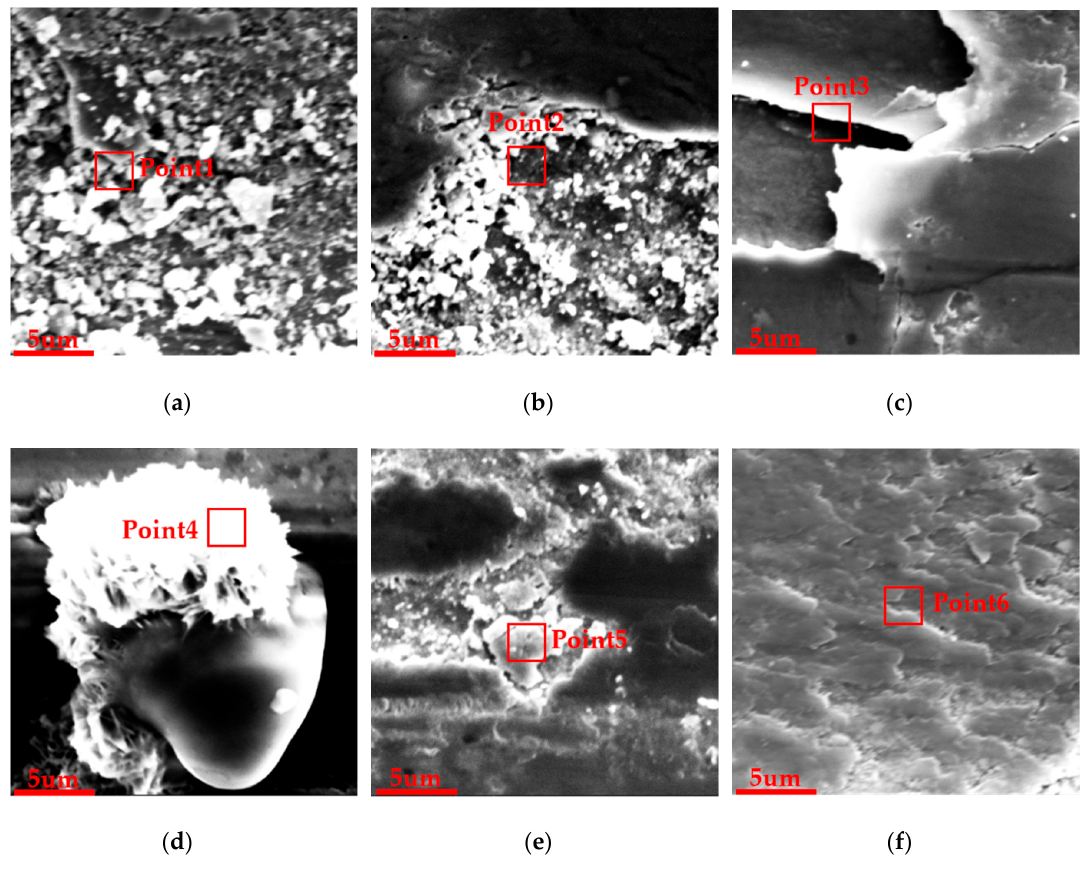
Figure 10. SEM results of the wear characteristics: ( a ) debris; ( b ) extrusion; ( c ) fracture; ( d ) micro- protrusion; ( e ) shedding; ( f ) ploughing. Table 4. EDS results of the wear characteristics (Atomic